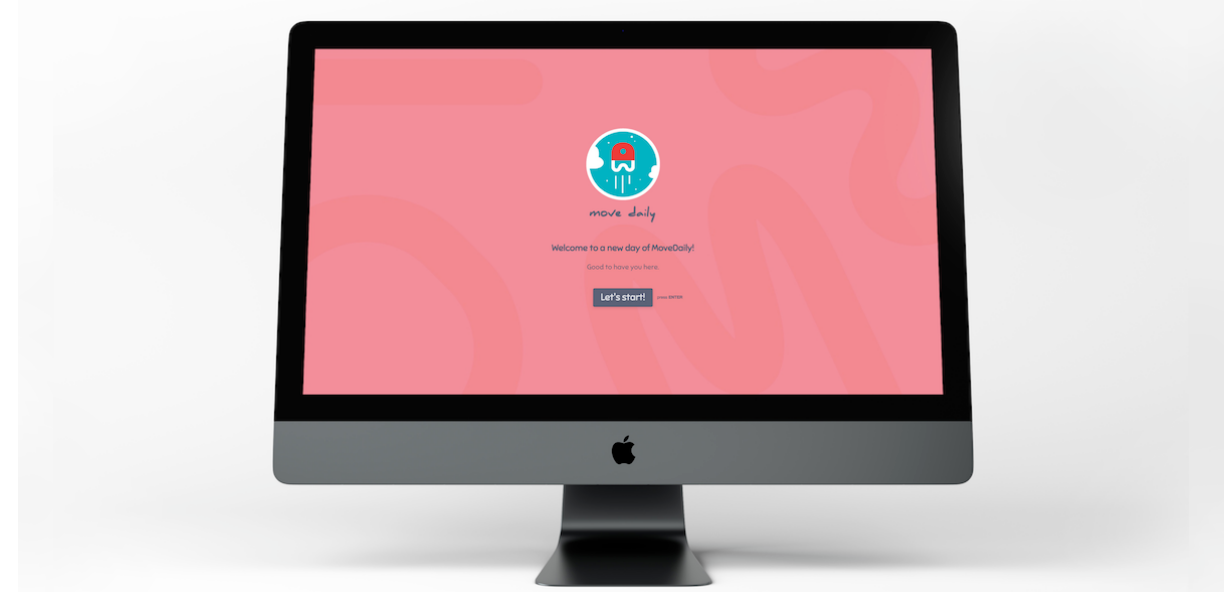
Figure 4. Screenshot of the web-based prototype for